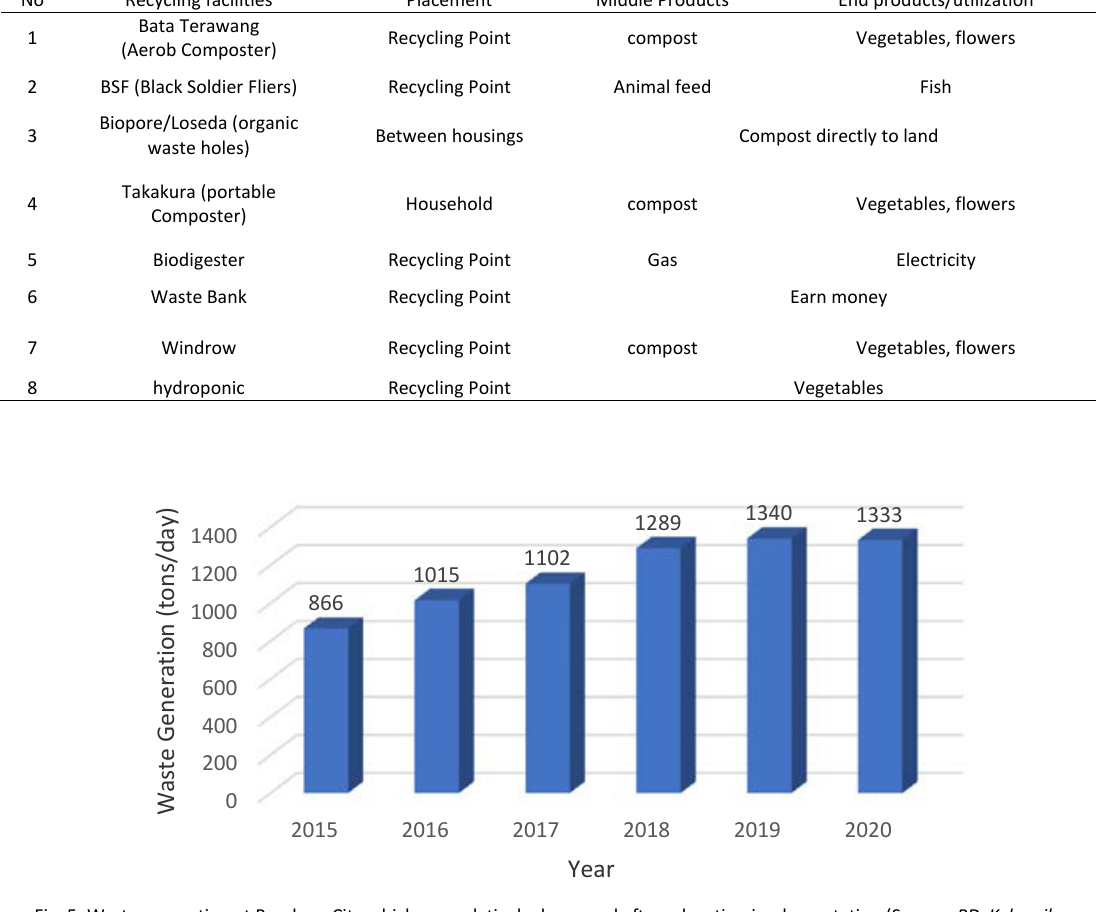
Fig. 5: Waste generation at Bandung City which was relatively decreased after education implementation (Source: PD. Kebersihan Archives) Tobago without external driver. Thus,